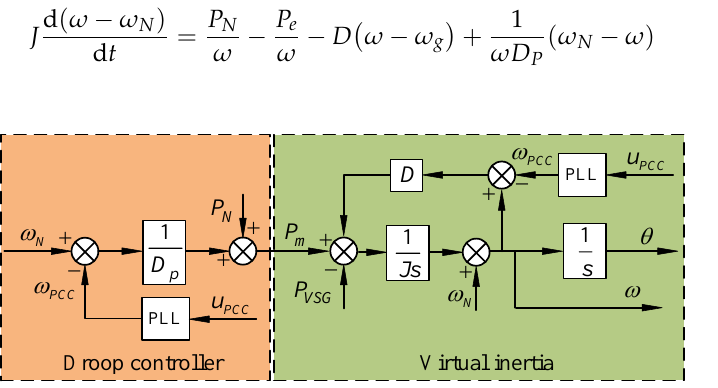
Figure 2. Active power controller of VSG.